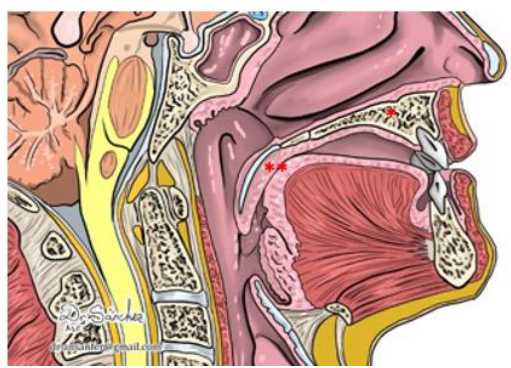
Figure 2. Normal position of the tongue.